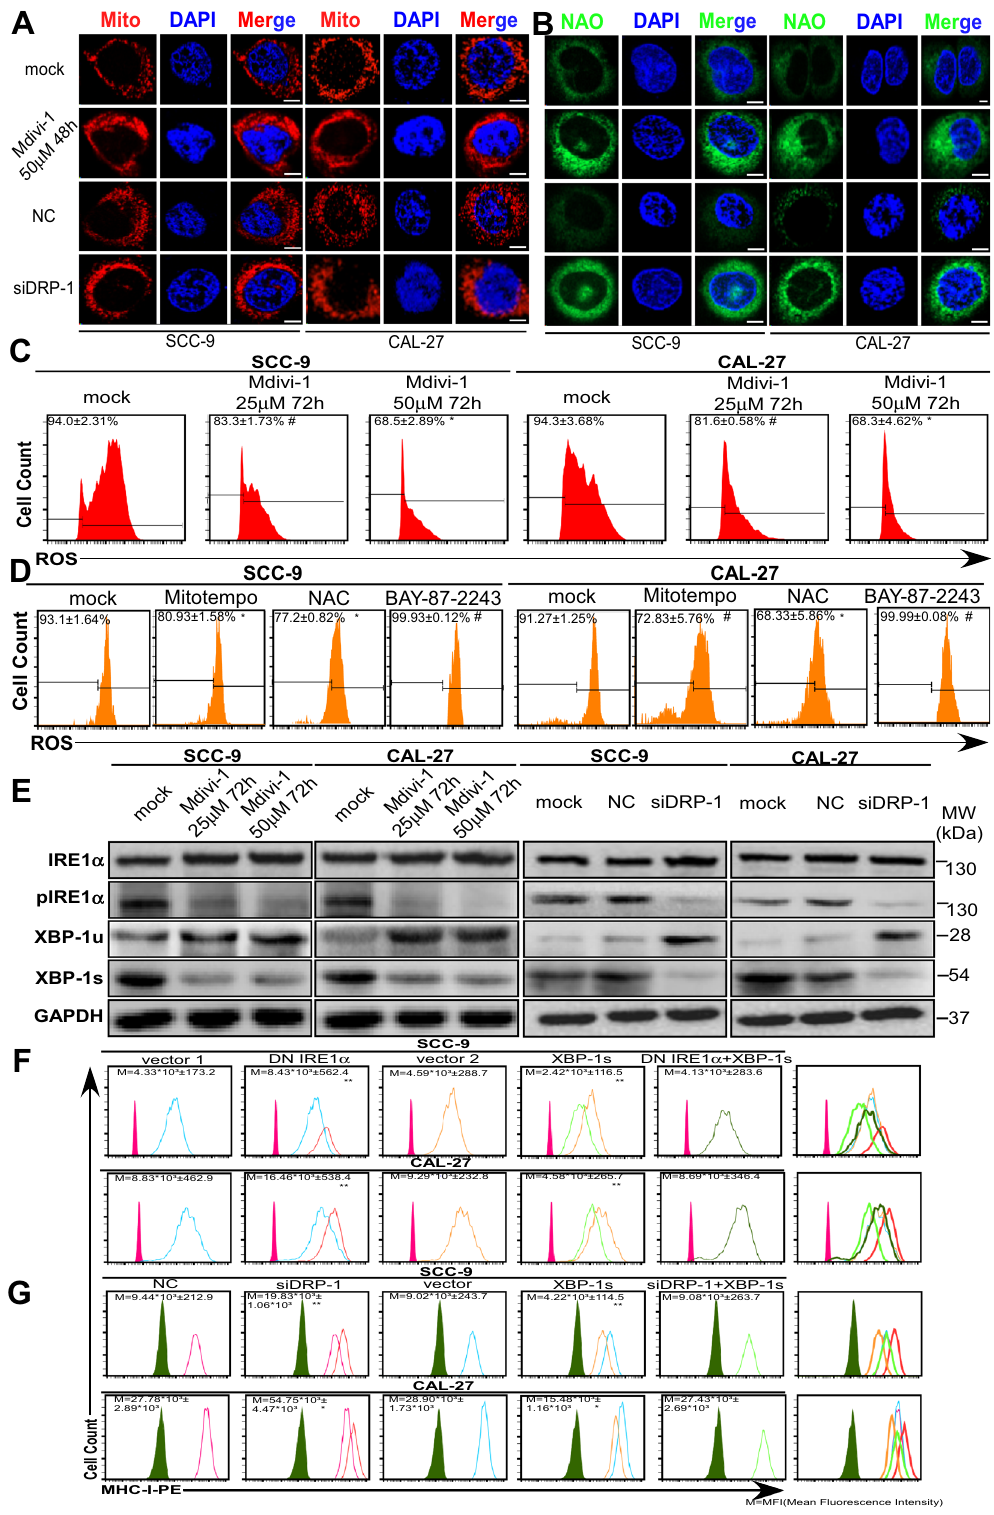
(ii) ER stress blocking protein synthesis via PERK-mediated proposed mechanisms are involved, we performed a microarray eIF2 α phosphorylation, contributing to diminished peptide analysis following XBP-1s knockdown in CAL-27 TSCC cells to generation 36 , and/or (iii) downregulation of other APM compo- identify 1276 differentially expressed mRNAs (Fig. 6A – C). Gene nents, such as the transporter associated with antigen presenta- set enrichment analysis (GSEA) revealed signi fi cant enrichment tion (TAP) involved in translocation of peptides from the cytosol ( q < 0.05) of several immune-, metabolism-, post-translational to the ER lumen where they are loaded onto HLA class I heavy modi fi cation- and cancer-related gene sets (Fig. 6C – E). Notably, chain- β 2 m dimers 36,37 . To determine whether any of these KEGG antigen processing/presentation genes and REACTOME NATURE COMMUNICATIONS| (2022) 13:3882